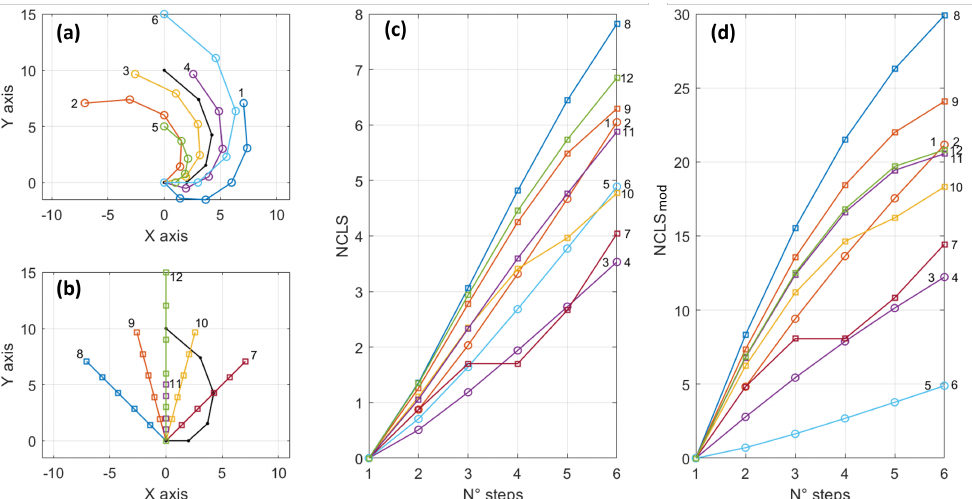
Figure A1. Comparison between NCLS and NCLS mod through artificial trajectories. ( a ) Artificial curved trajectories; ( b ) straight artificial trajectories; ( c ) estimated performance through NCLS; and ( d ) estimated performance through NCLS mod .